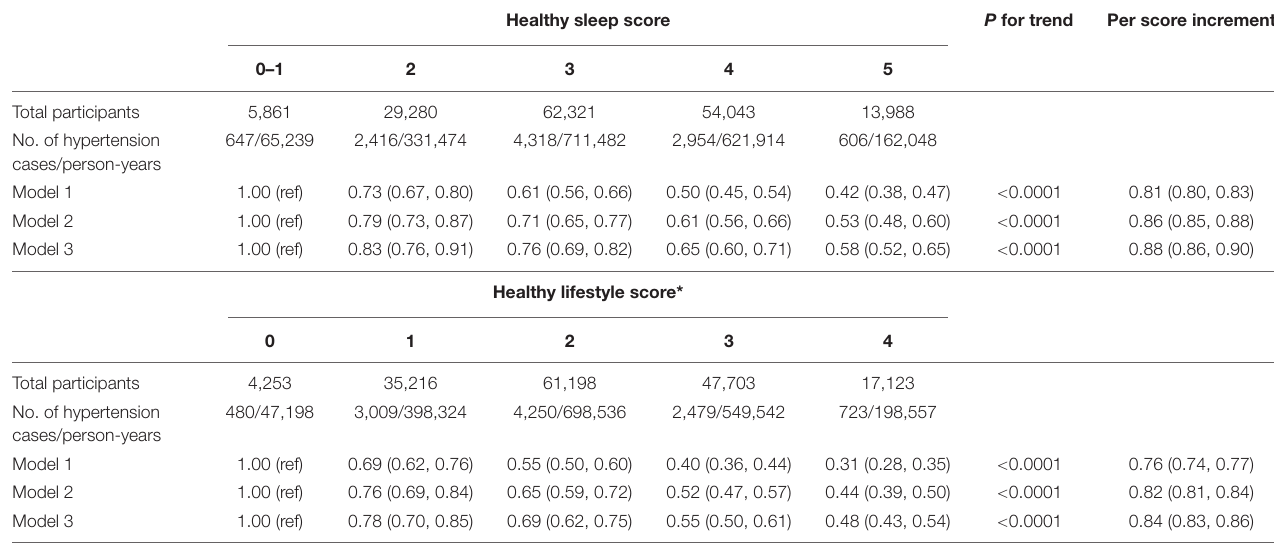
TABLE 2 | Hazard ratios (HRs) for hypertension by healthy sleep score or healthy lifestyle score among 165,493 participants. Healthy sleep score P for trend Per score